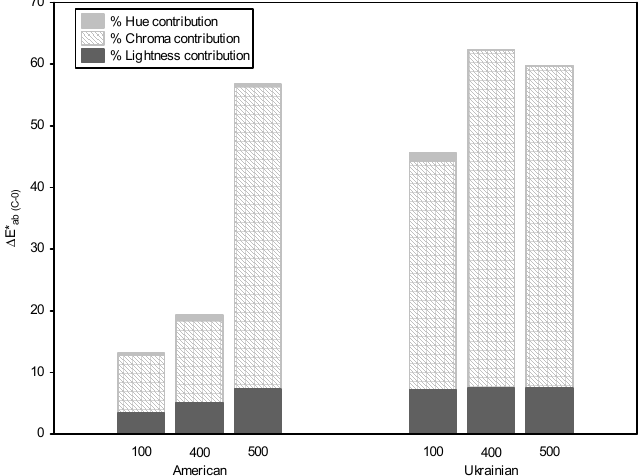
Figure 3. Total color di ff erence induced by copigmentation ( ∆ E* ab (C-0) ), between the color of the control solution and the color of the model solutions with di ff erent TPC from American (AOW) and Ukrainian (UOW) shavings. Relative contribution of chroma, lightness and hue (% ∆ C , % ∆ L , % ∆ h ) to the color di ff erence.